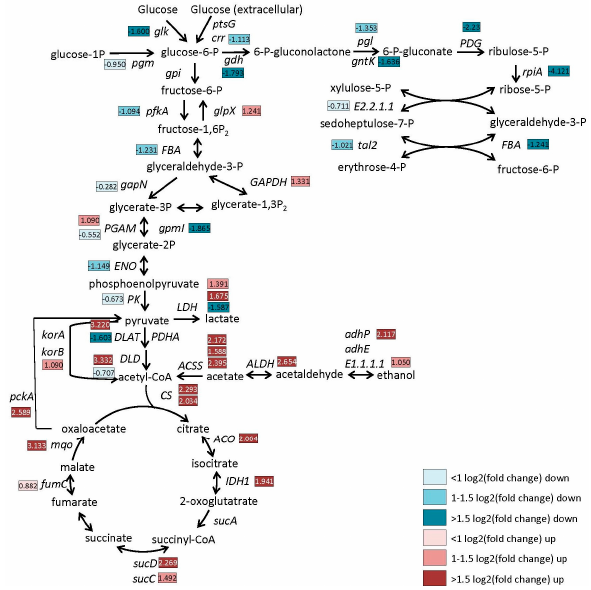
Figure 6. Enzyme levels (log2 (fold changes)) in central metabolic pathways of B. cereus strain M001 spores compared to levels in WT spores. Enzyme levels in blue are reduced, while those in red are increased. The multiple boxes next to some enzymes correspond to isoforms of the same enzyme. The regulation of the relevant genes and the enzymes for which they are coding are presented in Supplementary Table S3.